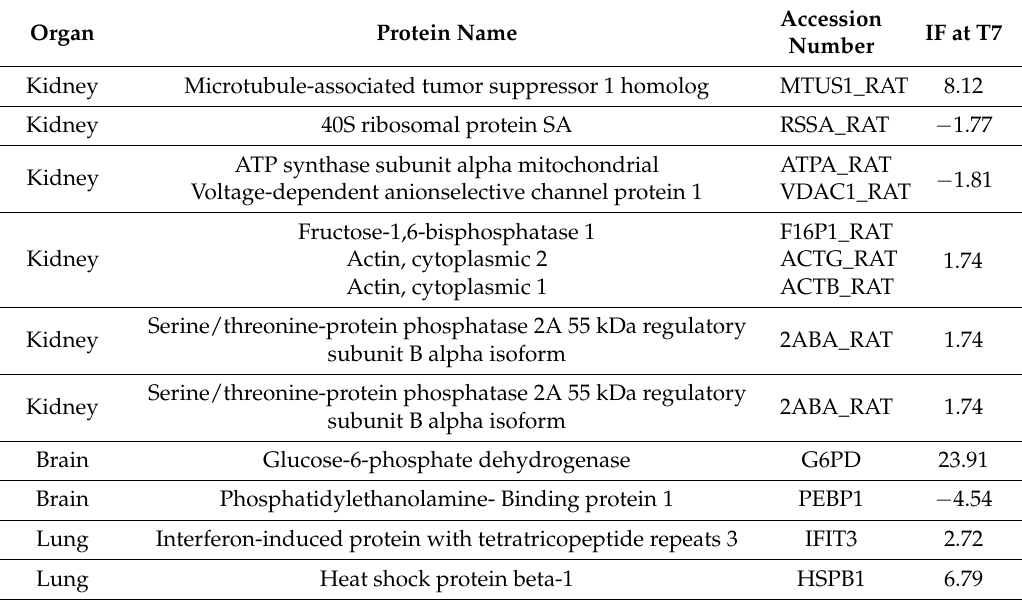
Table 5. Significantly regulated proteins 7 days after hyperoxia (T7) in different organs. Positive values express up-regulation ( n = 7), negative values down-regulation ( n =